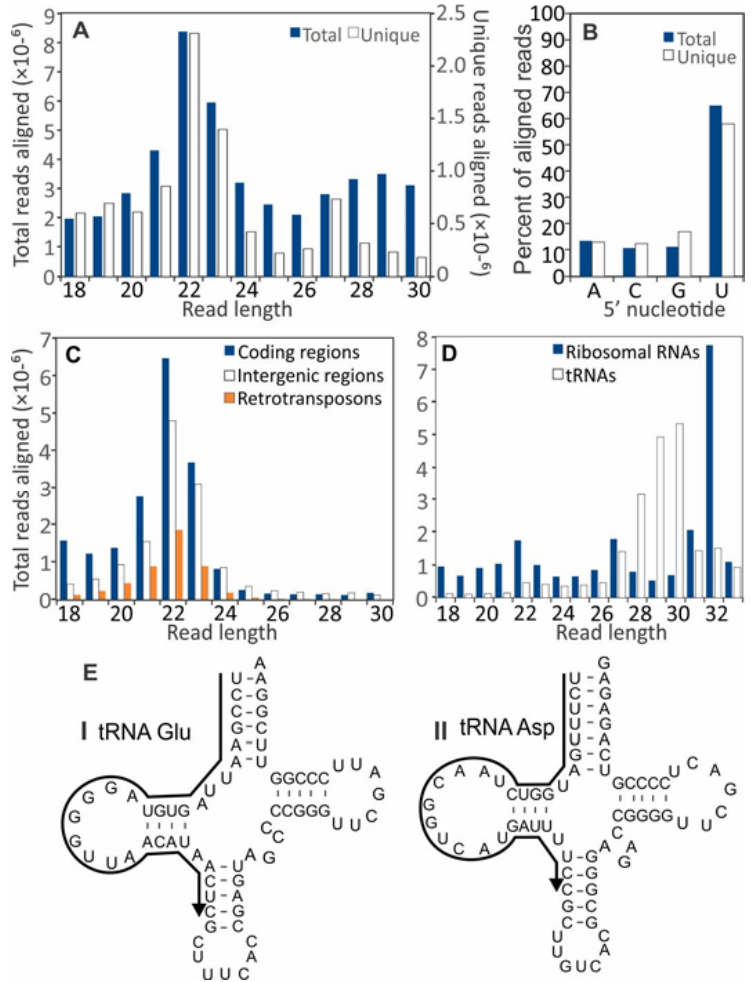
Figure 1. Size distributions of small RNA sequences that aligned to the S . sclerotiorum genome. ( A ) Size distribution of small RNA libraries from combined virus-free and hypovirus-infected S . sclerotiorum cultures. White and black columns represent unique and total reads of the sRNAs, respectively. ( B ) Frequency of 5 (cid:48) terminal nucleotides from pooled small RNA samples. Size distribution of small RNA reads aligning to ( C ) coding regions, intergenic regions, retrotransposon sequences, and ( D ) ribosomal RNA and tRNA sequences. ( E ) Mature tRNA structures predicted by tRNAscan-SE with sequences of the two most abundant small RNA sequences that resembled stress-induced